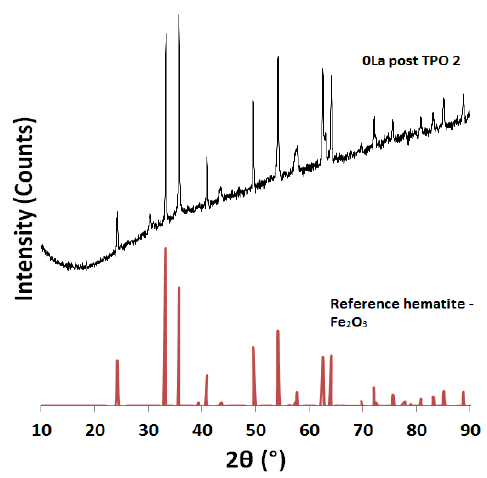
Figure 5. XRD of 0La catalyst after the final temperature-programmed oxidation. The catalyst is oxidized with Fe 2 O 3 as the major bulk phase of iron.